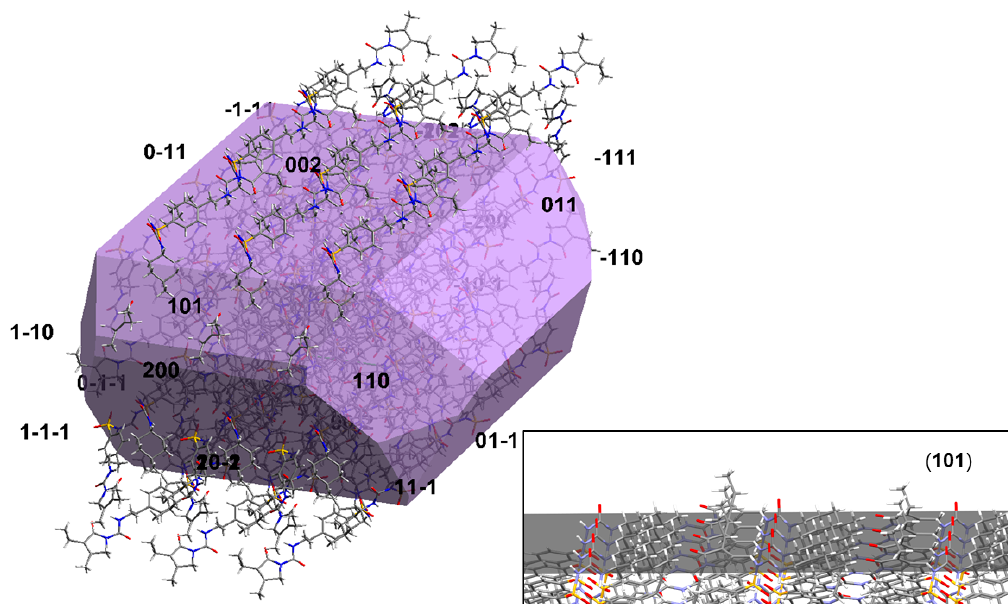
Figure 8. Crystal morphology of glimepiride calculated according to the attachment energy theory, featuring the orientation of a 3 × 3 supercell relevant to the crystal. The surface chemistry of the (101) Miller plane is illustrated in the insert.